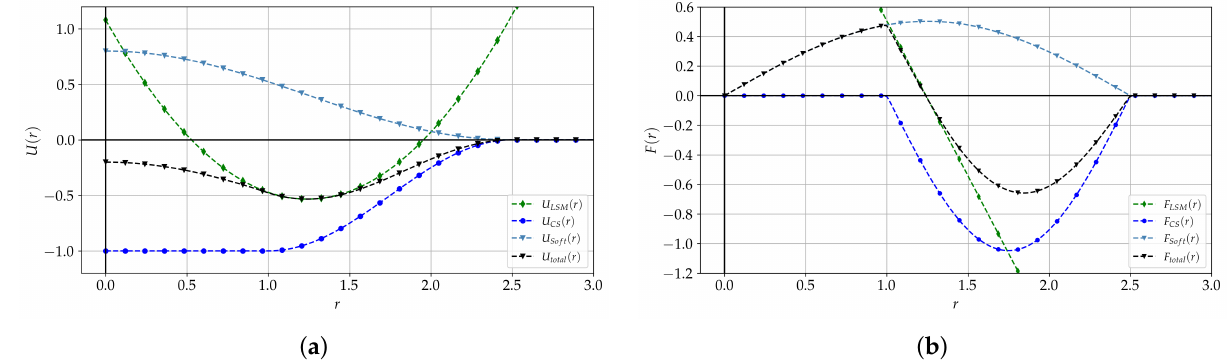
Figure 7. Comparison of energy potentials and forces used for modelling elastic behaviour. LSM : Lattice-Spring-Model potential; CS : Attractive potential (Cosine/squared); Soft : Repulsive potential (Soft); Total : Combined Soft-Cosine/Squared potential. Curves obtained for (cid:101) CS = 1, (cid:101) Soft = 0.4 (cid:101) CS , σ = 1, r c , CS = r c , Soft = 2.5. ( a ) Energy potentials. Location of the harmonic LSM potential adjusted for illustration purposes. ( b ) Force field obtained with elastic, attractive, repulsive, and total